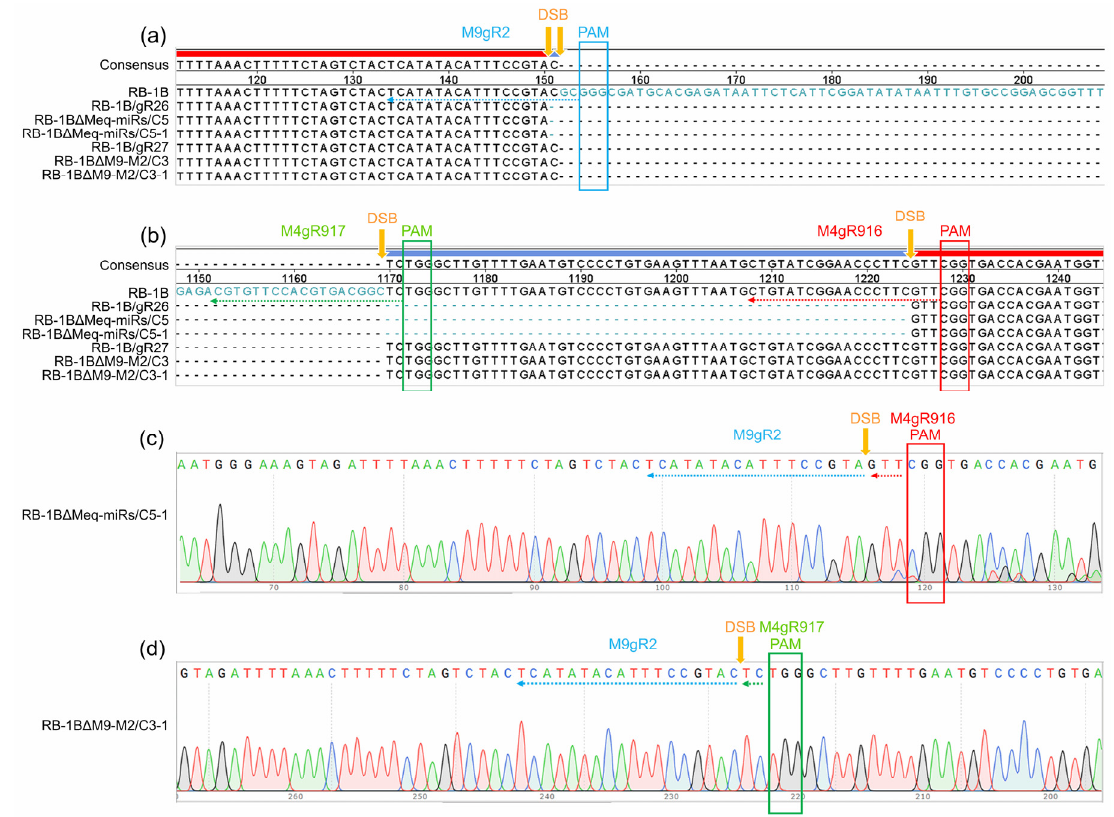
Figure 3. Sequence alignment and identification of the gRNA-mediated Meq-clustered miRNA mutagenesis in RB-1B viral genome. ( a , b ) Alignment of the miRNA genes in primarily mutated RB-1B and purified progeny mutants. ( c , d ) Demonstration of the double strand breaks (DSBs) in the targeted miRNA genes. The entire or broken gRNA sequences and protospacer adjacent motifs (PAMs) are shown by same colored arrows or square frames, respectively.